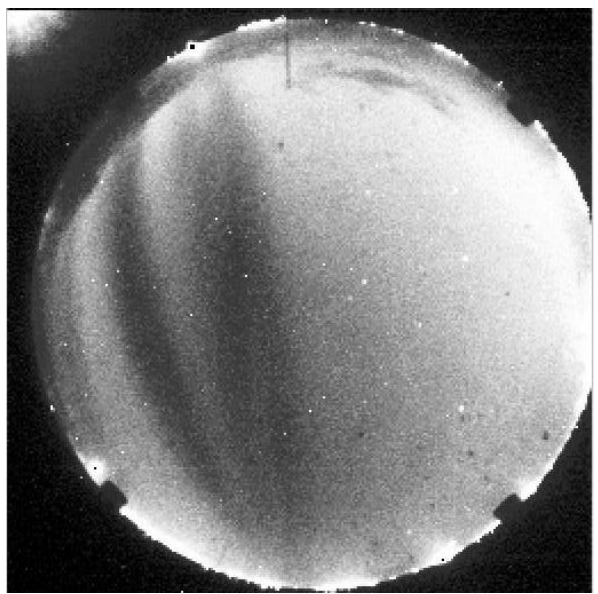
Fig. 2. Typical all-sky image over Asmara in late morning. The outer edge of the disk corresponds to the horizon and the center to zenith. North is to the top and east is to the right. The large black streaks are